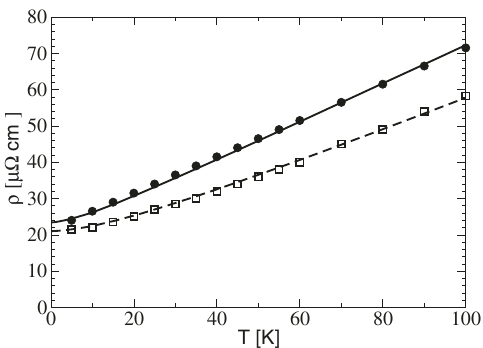
Fig. 2 Linear-in- T resistivity. Resistivity calculations for a Nd- La 2 − x Sr x CuO 4 sample with x = 0.24 (black solid line) and for a Eu- La 2 − x Sr x CuO 4 sample with x = 0.24 (black dashed line). The symbols refer to the experimental data extracted from ref. 26 (the error bars of the data are smaller than the symbol size): fi lled circles for Nd-La 2 − x Sr x CuO 4 and empty squares for Eu – La 2 − x Sr x CuO 4 . For the fi tting we used a quasiparticle- charge fl uctuations coupling and the elastic scattering rate due to quenched disorder g 2 = 0.045 and Γ 0 = 13.7 meV for Nd – La 2 − x Sr x CuO 4 and g 2 = 0.0415 and Γ 0 = 12.3 meV for Eu – La 2 − x Sr x CuO 4 (see Methods — the Boltzmann equation and calculation of the electron scattering Nd-La 2 − x Sr x CuO 4 and we therefore use similar values: m = (cid:1) Ω ¼ 30 meV. These values corre- 10 meV, (cid:1) ν ¼ 1 : 3 eV (r.l.u.) − 2 , spond to a rather short coherence length of a few lattice spacings, ffiffiffiffiffiffiffiffiffi ξ (cid:2) 1 ¼